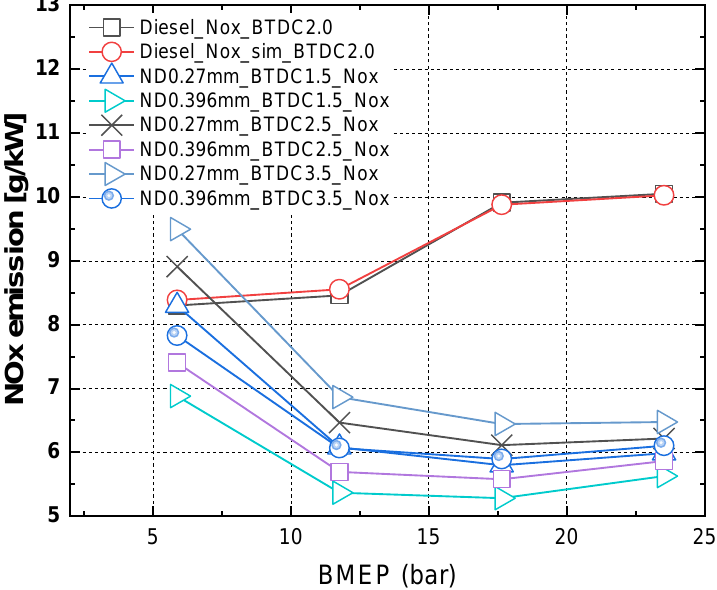
Figure 7. Characteristics of NOx emission versus start of injection timing and nozzle hole diameter for marine diesel fuel and DME fuel.